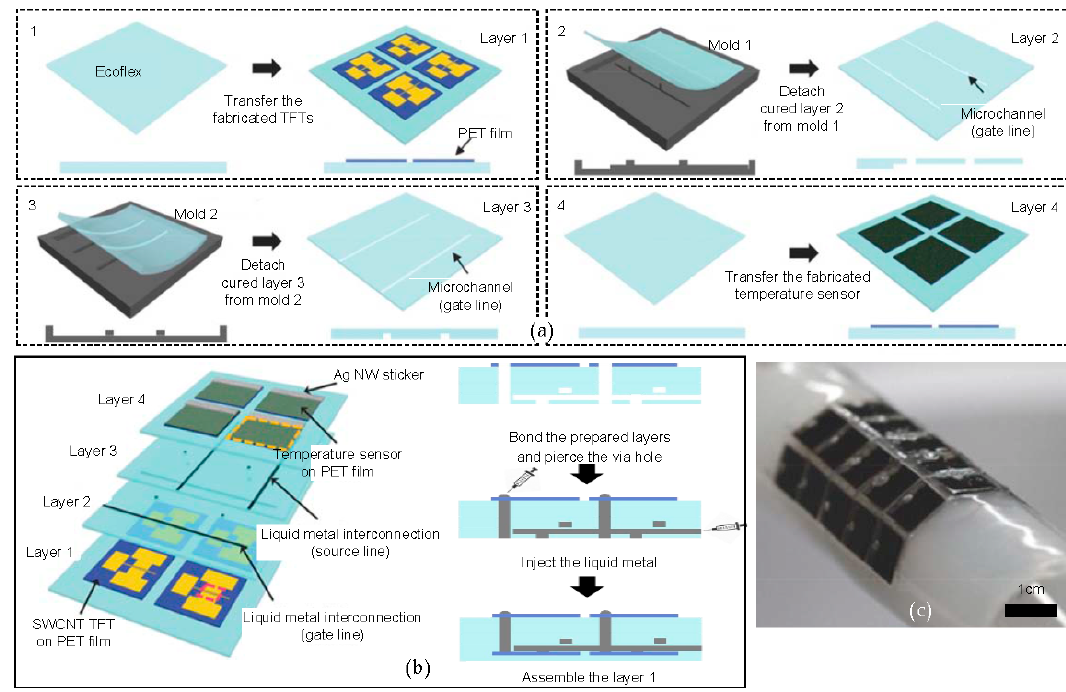
Figure 9. Stretchable temperature sensor array for electronic skin. ( a ) A schematic of the fabrication of the flexible and stretchable active matrix temperature sensor array; ( b ) the vertical schematic view of the sensor (left) and injected liquid metal for gate/source lines; ( c ) an optical image of the bent sensor with a radius of 14 mm. Reproduced with permission from 2016 Advanced Materials [91].